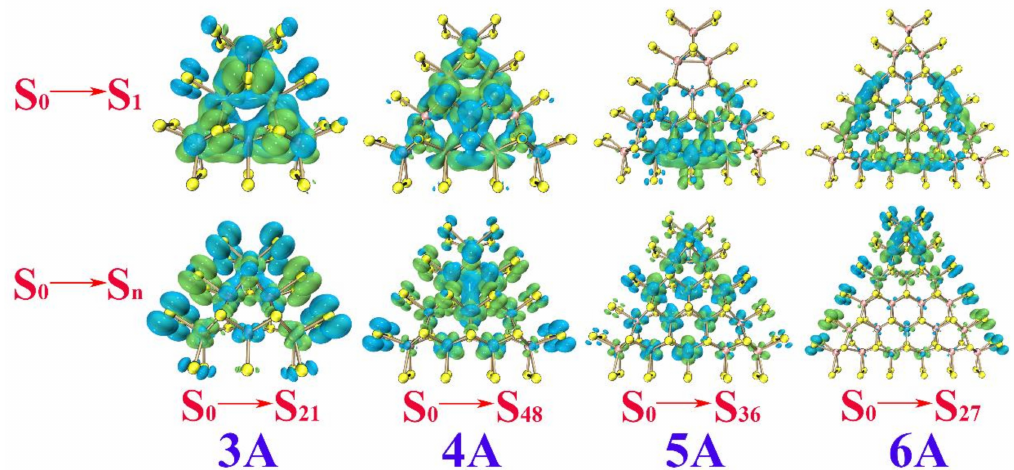
Figure 4. Electron (green) and hole (blue) distributions with isosurface 0.0006 for 3A , 4A , 5A and 6A .